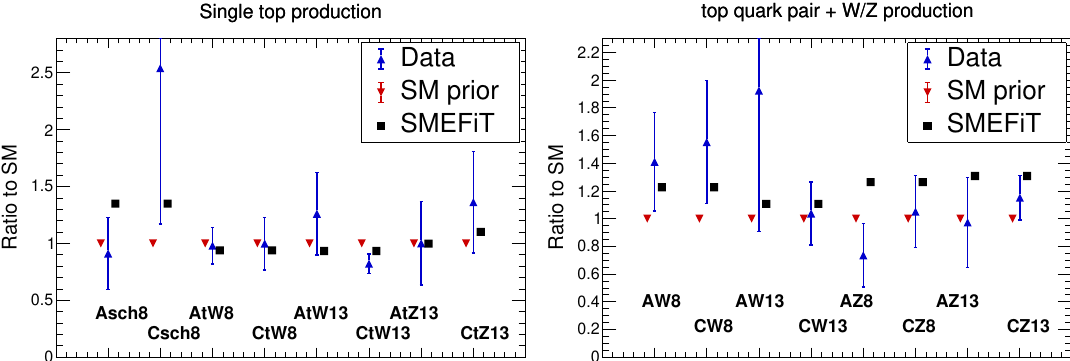
Figure 15 . Left: the ATLAS (A) and CMS (C) measurements for single top production in the s - channel and in the tW and tZ associated production channel. Right: the corresponding comparison of the cross-section of t (cid:22) t associated production with W and Z vector bosons. We show the results for the most updated measurements both at 8 TeV and at 13